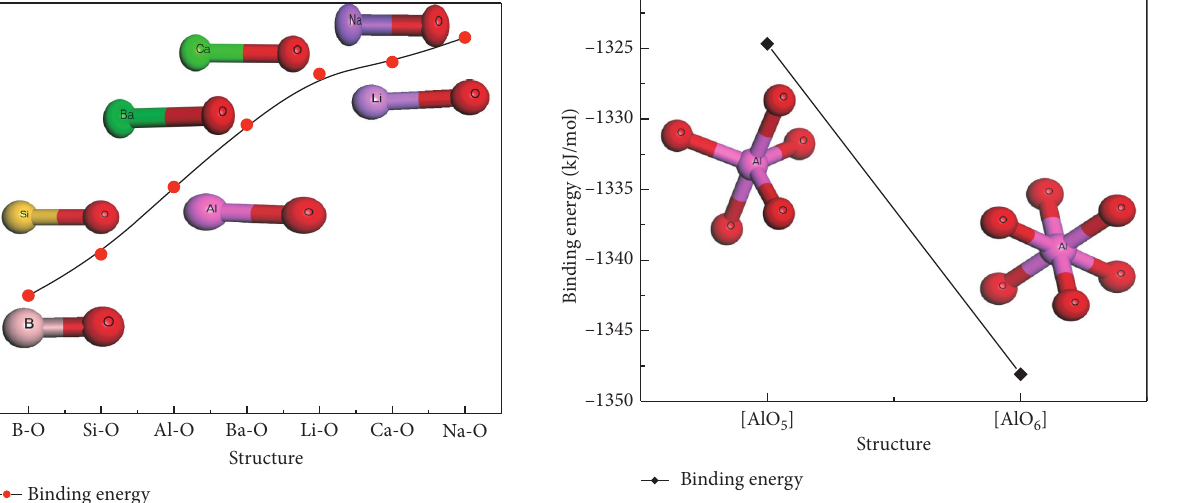
Figure 1: Structural diagram showing the binding energy of B-O, Si-O, Al-O, Ba-O, Li-O, Ca-O, and Na-O.